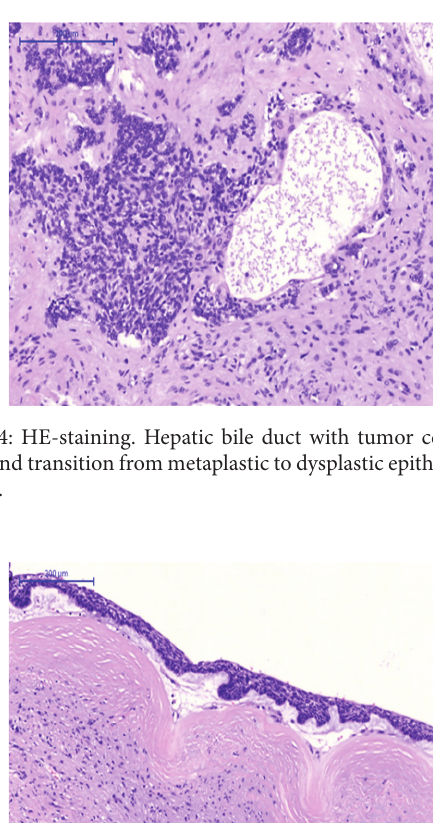
MUC5AC, MUC2, synaptophysin, vimentin, and glypican were all negative.